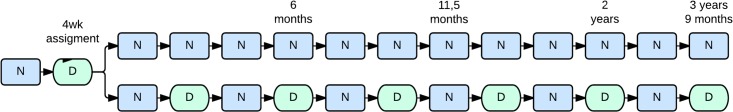
Flow chart experiment schedule (upper row) versus regular schedule (lower row).N = Nurse; D = Doctor